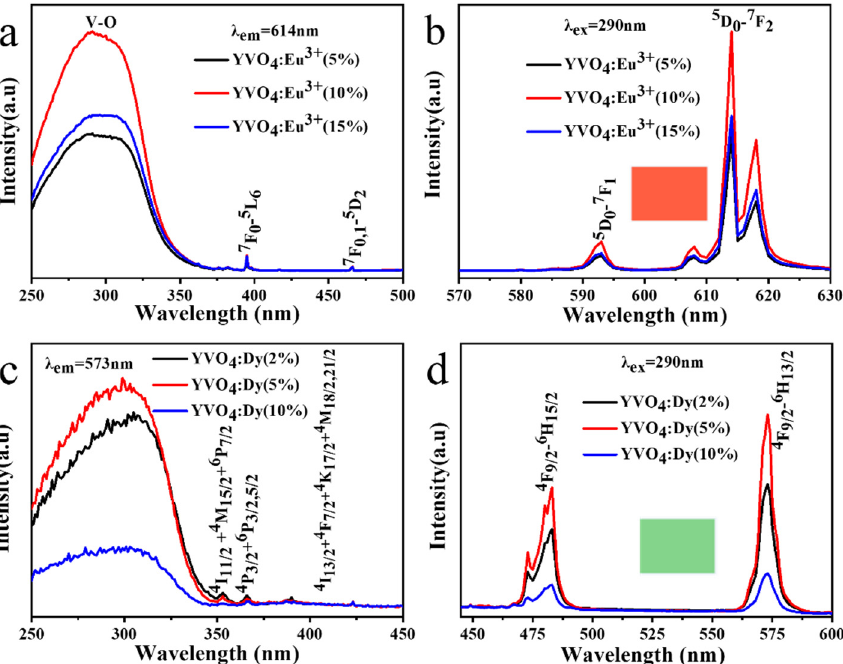
Figure 6 . The excitation spectra ( a ) and emission spectra ( b ) of Y 1 − x Eu x VO 4 films prepared for 1 h, excitation spectra ( c ) and emission spectra ( d ) of Y 1 − x Dy x VO 4 films prepared for 1 h. Insets in ( b ) and ( d ) show red emission and green emission of the (Y 0 . 90 Eu 0 . 10 )VO 4 film and (Y 0 . 95 Dy 0 . 05 )VO 4 film under the UV excitation at 254 nm, respectively.